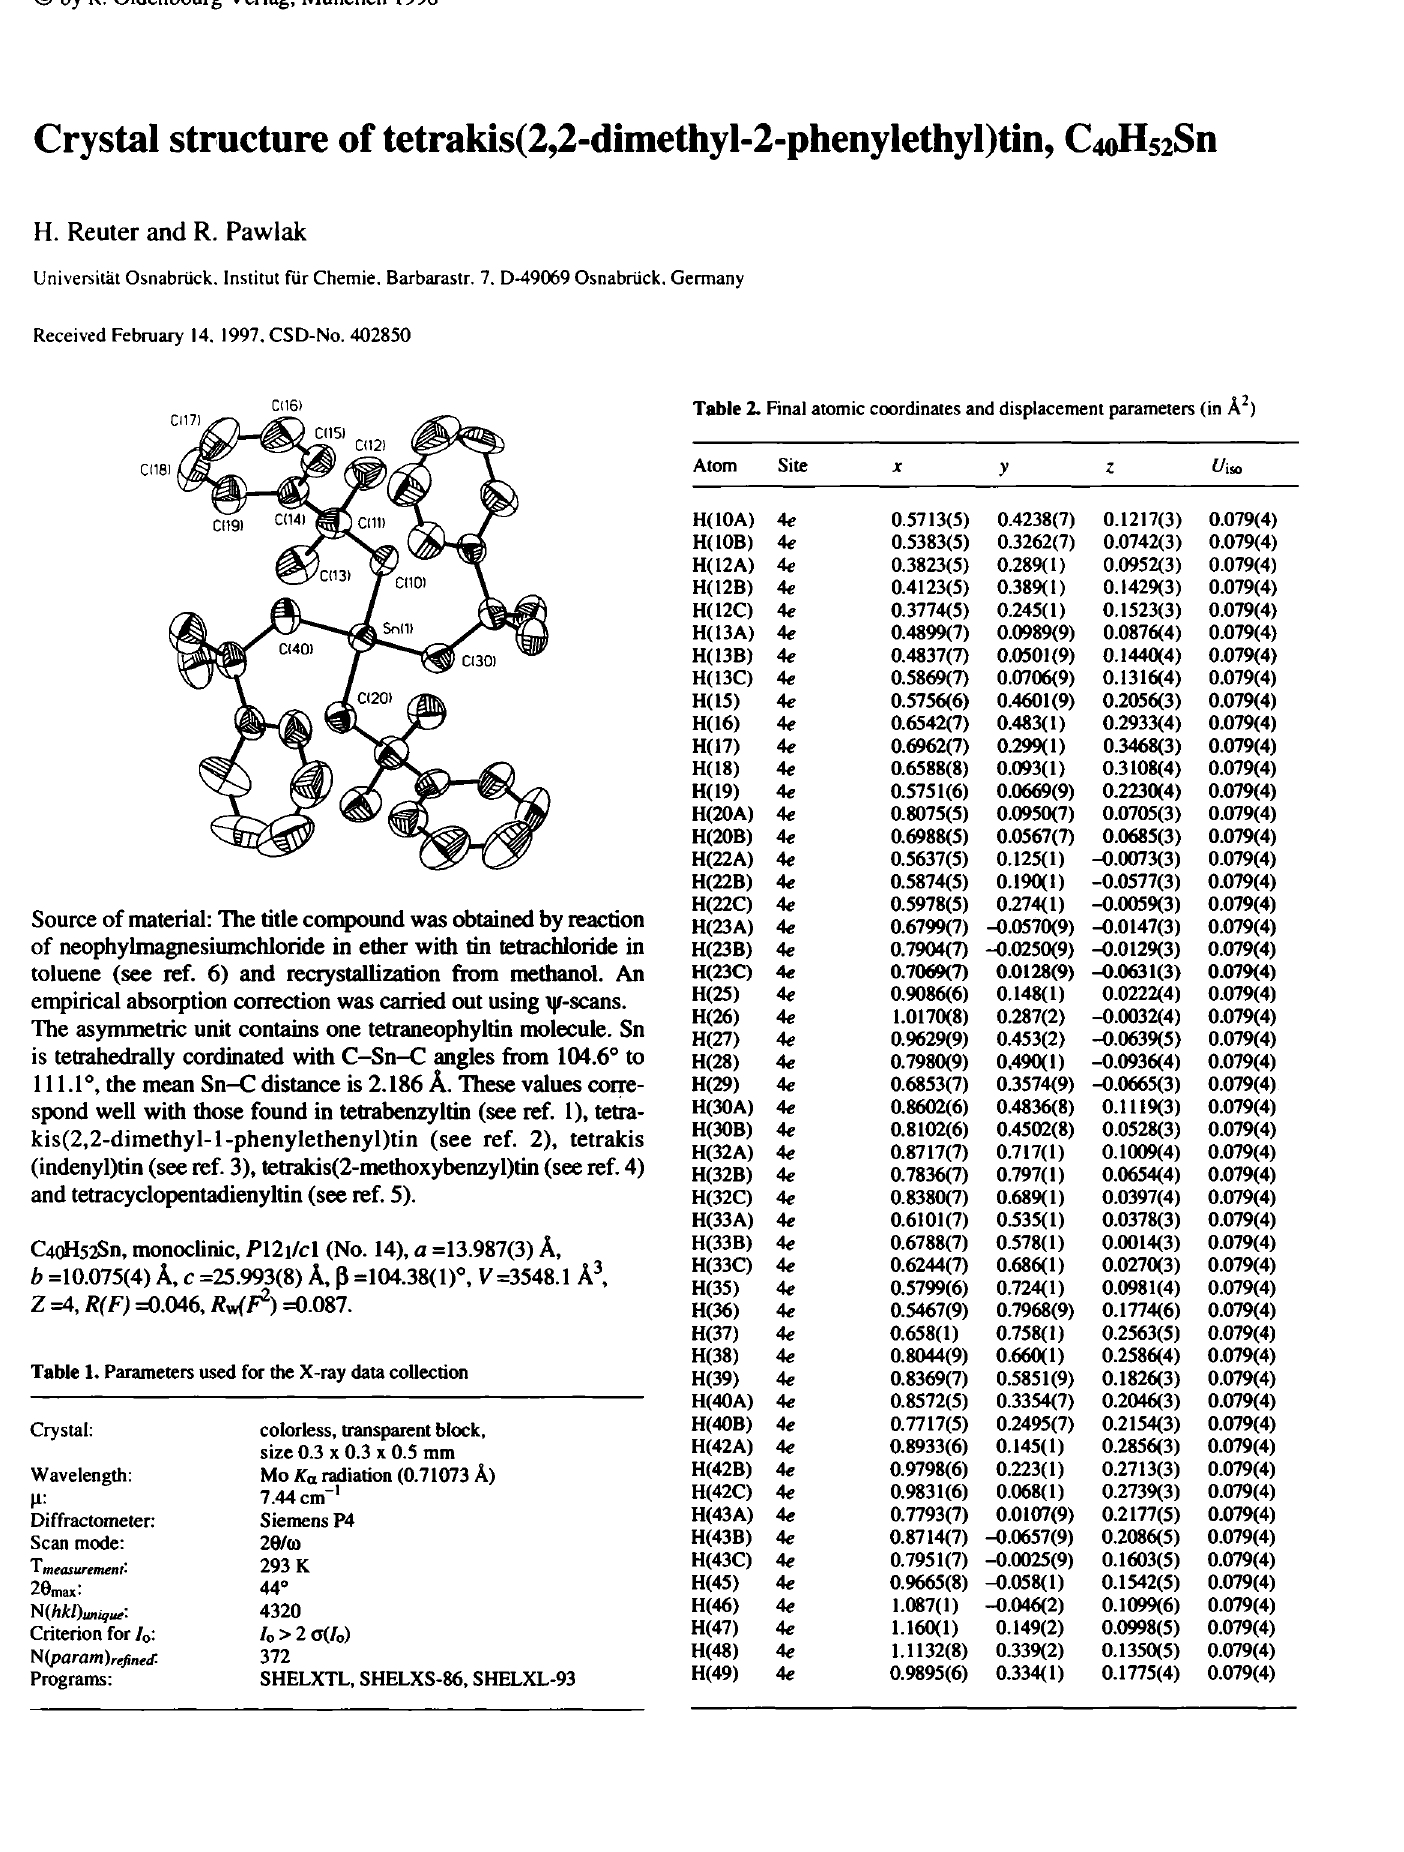
Table 2. Final atomic coordinates and displacement parameters (in A^)